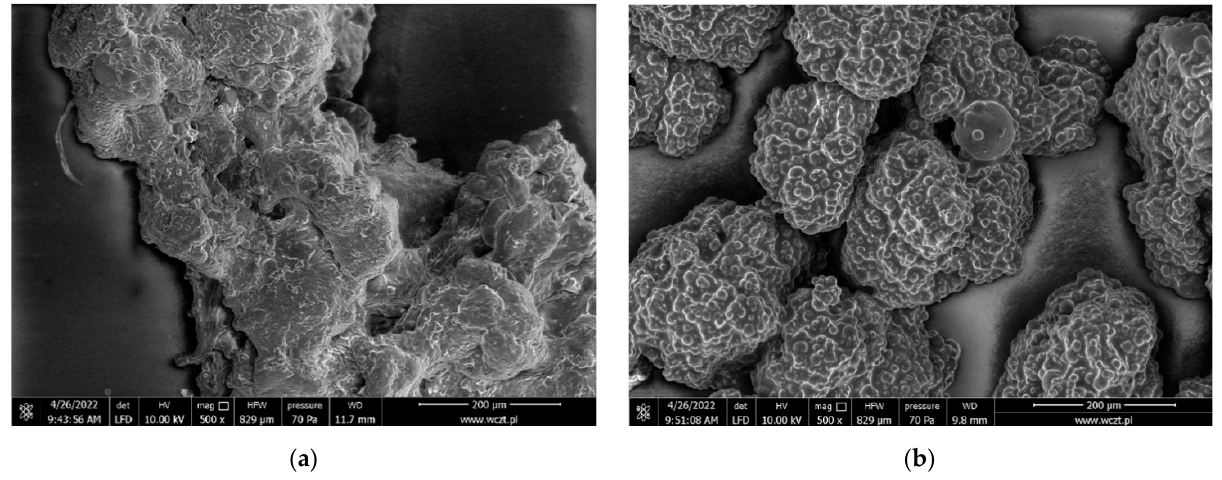
Figure 10. Scanning electron micrographs of gelatin capsules without and with gemini